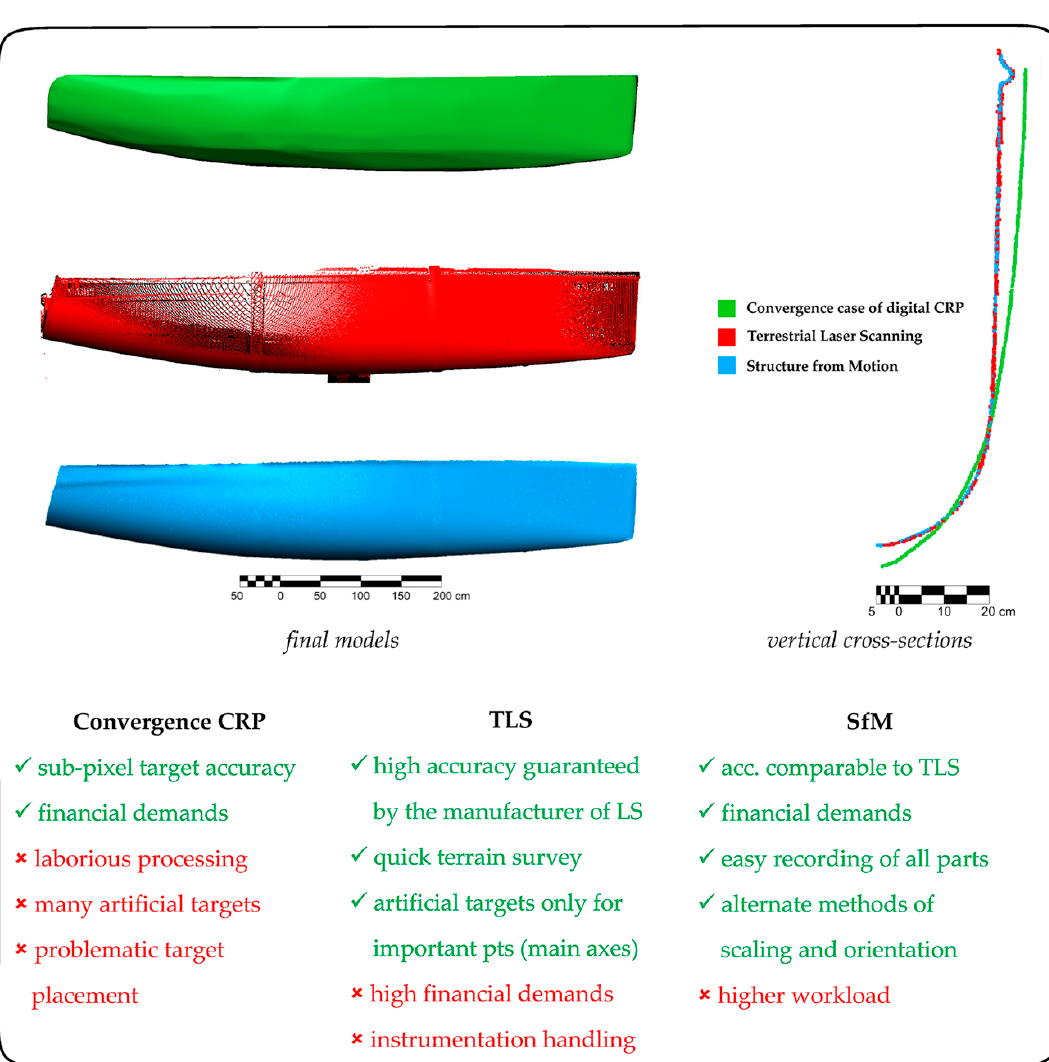
Figure 19. The final comparison of methods.